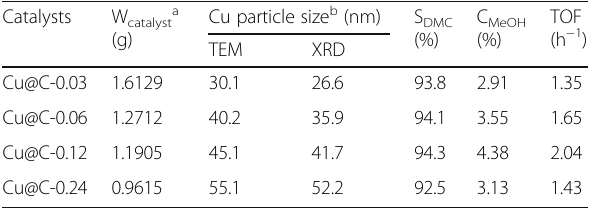
Table 2 Catalytic performance of Cu@C-X (X = 0.03, 0.06, 0.12, 0.24) catalysts with different Cu core sizes Catalysts